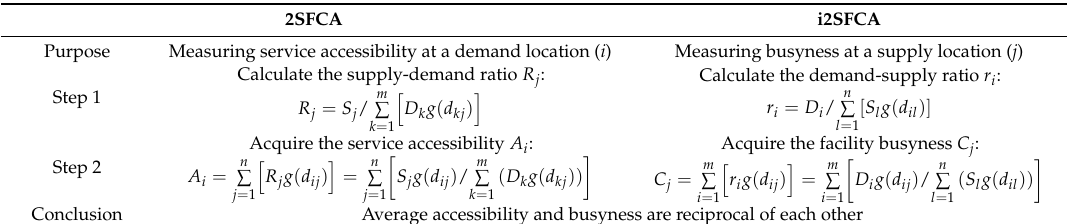
Table 1. Comparison of 2SFCA (two-step floating catchment area) and i2SFCA (inverted two-step floating catchment